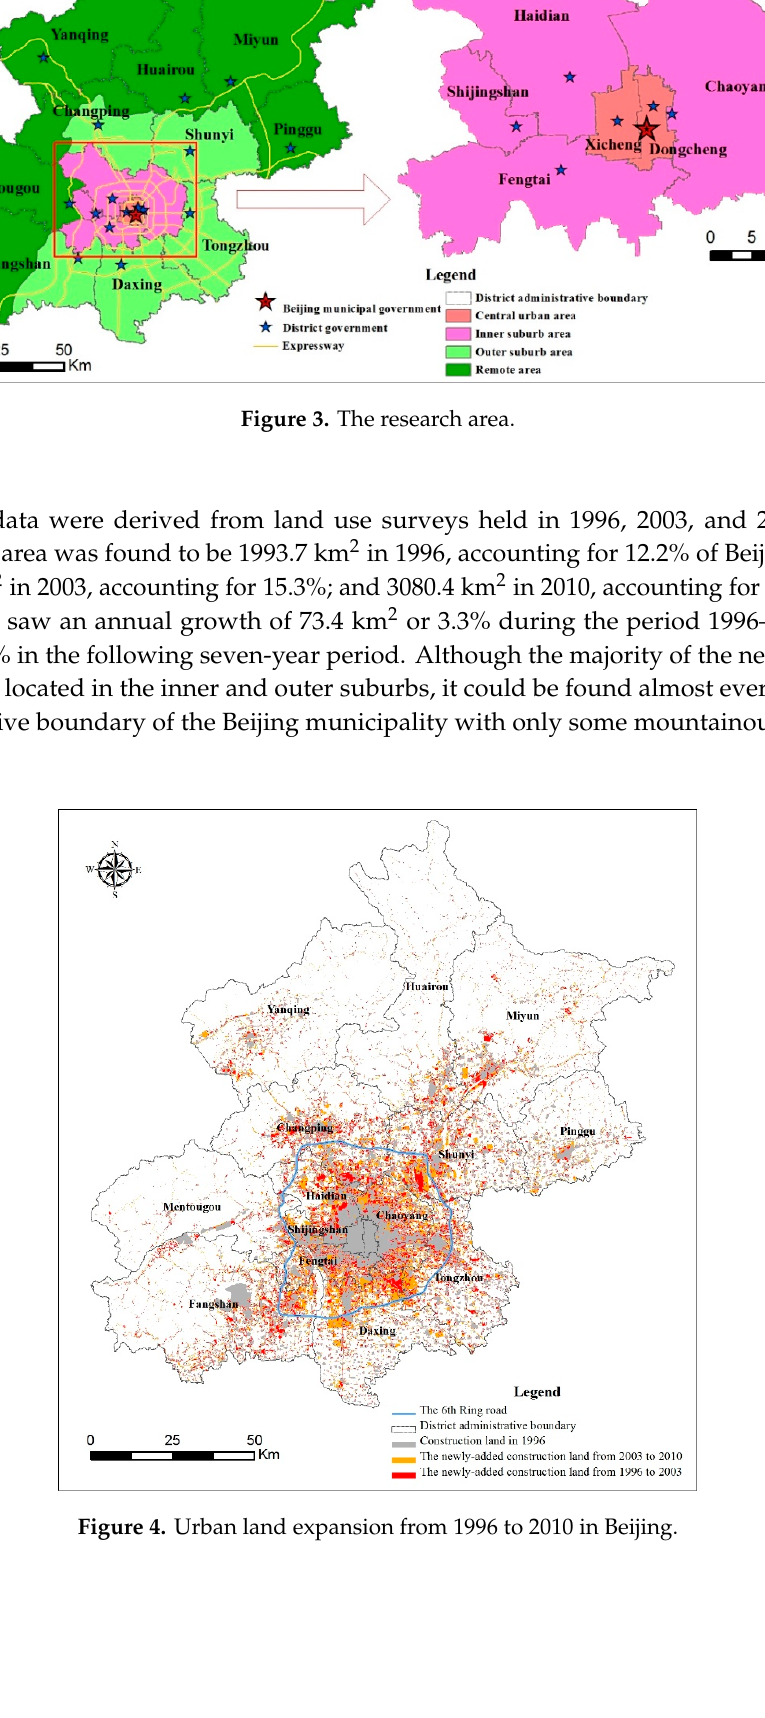
Figure 4. Urban land expansion from 1996 to 2010 in Beijing.